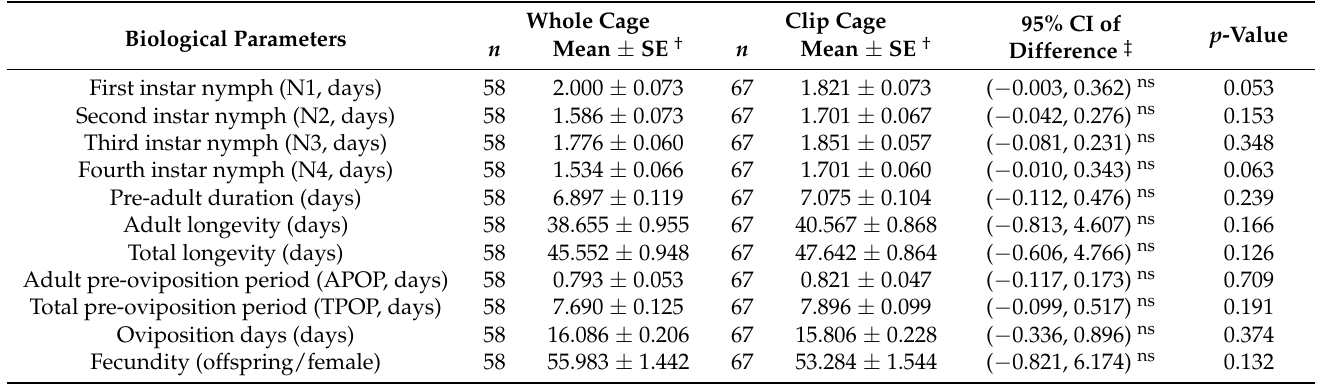
Table 1. Biological parameters of Sitobion avenae confined to clip cages and whole cages.